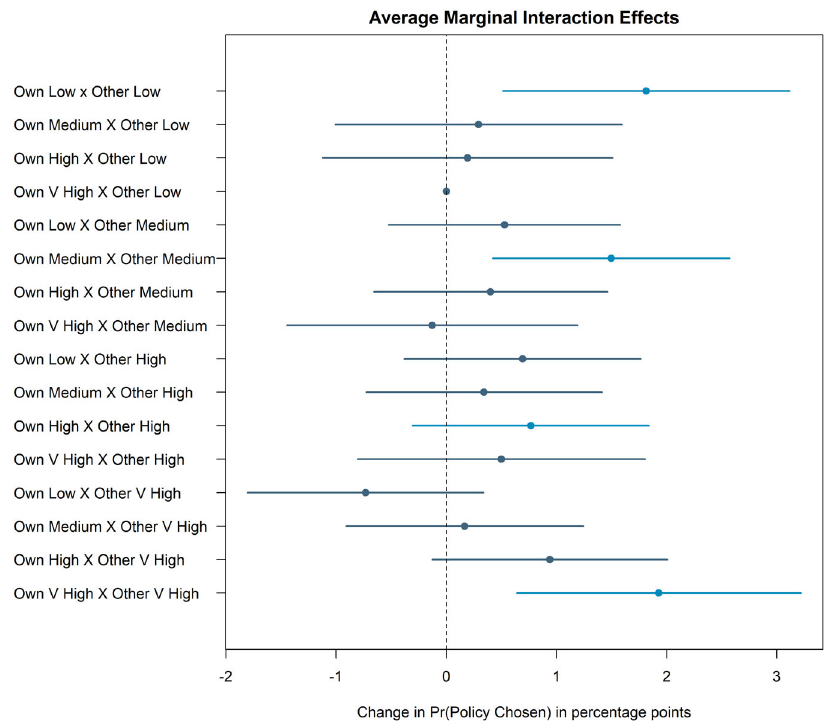
Fig.5|Averagemarginalinteractioneffectsofexactreciprocity(matchingown and other costs) on public support in France, Germany, United Kingdom, and the United States ( N =129,280). This plot reports average marginal interaction